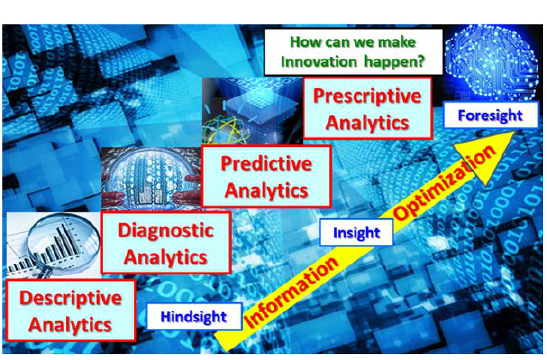
Figure 4. Four levels (phases) of the Data Analytics Hierarchy